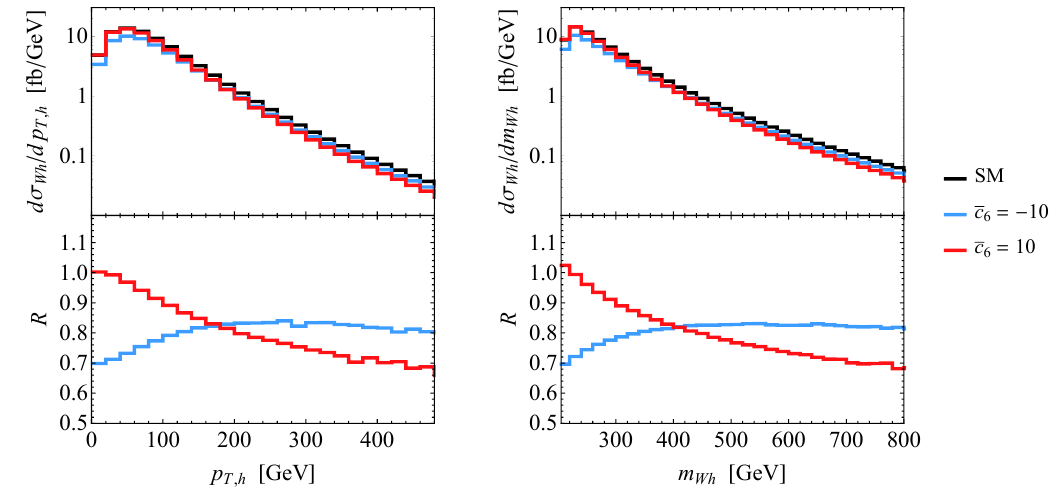
Figure 6 . Comparison of the p T;h (left) and m Wh (right) spectrum in Wh production. The upper panels show the SM predictions (black) as well as the cases (cid:22) c 6 = (cid:0) 10 (blue) and (cid:22) c 6 = 10 (red). The ratios between the case (cid:22) c 6 = (cid:0) 10 and the SM (blue) and the case (cid:22) c 6 = 10 and the SM (red) are displayed in the lower panels. All results correspond to pp collisions at